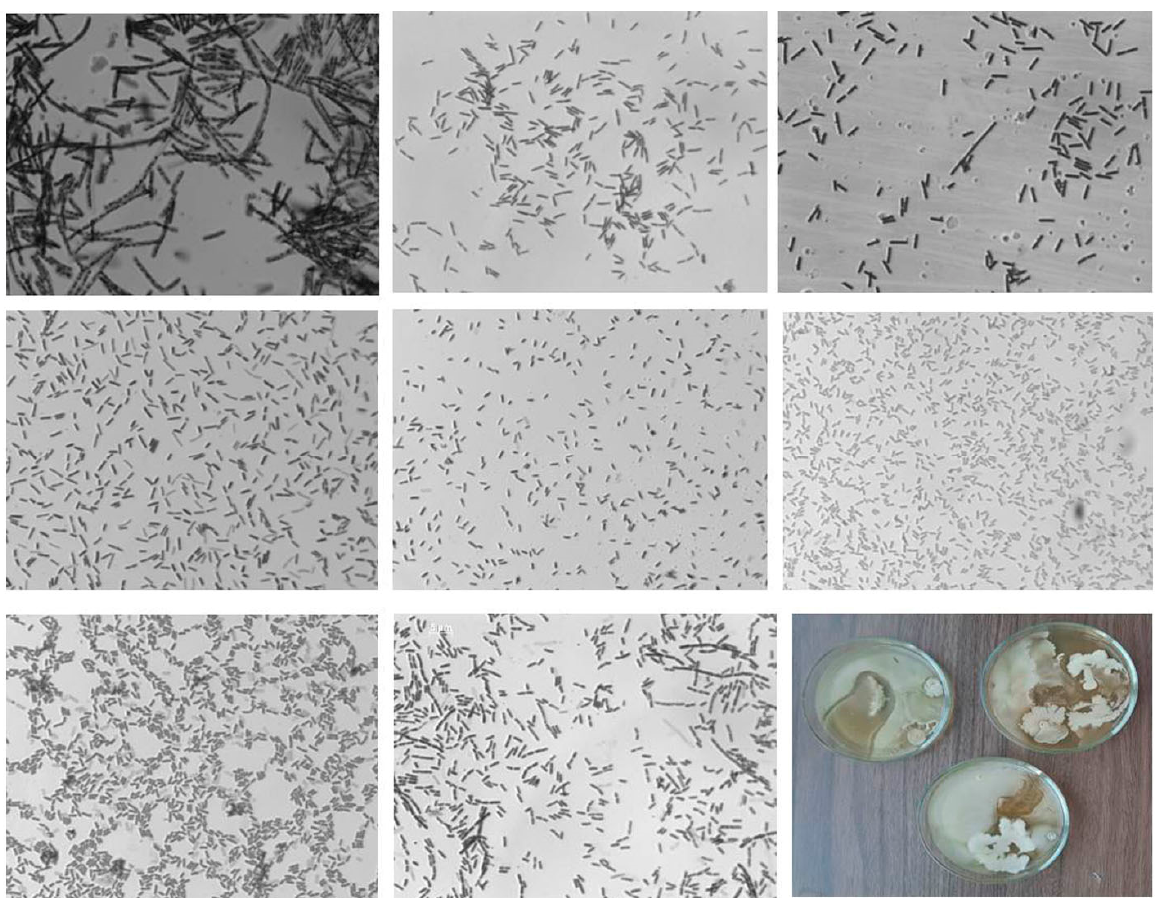
Figure 4. Photo of bacteria sown from potato tubers treated with Se/ST NC (1000× zoom).